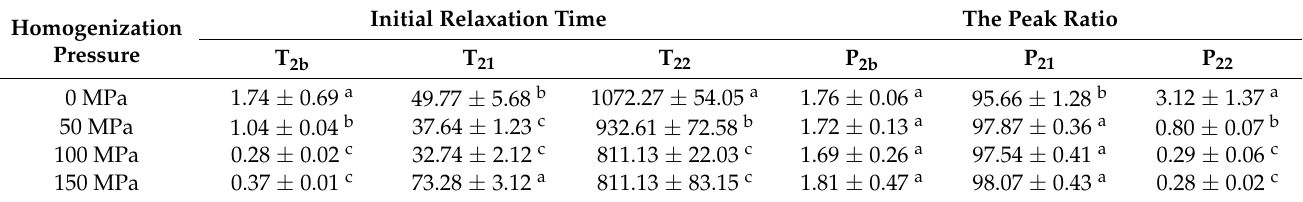
Figure 3. The changes of LF-NMR relaxation time of cooked pork myofibrillar protein with high- pressure homogenization-modified soy 11S globulin. Table 3. The initial relaxation time (ms) and peak ratio (%) of cooked pork myofibrillar protein with high-pressure homogenization-modified soy 11S globulin.